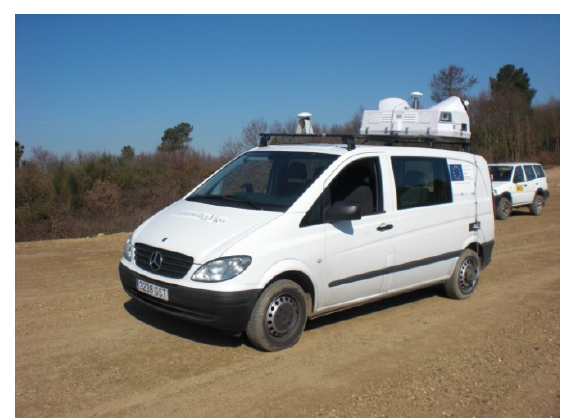
Figure 2. Mobile LiDAR Optech Lynx.